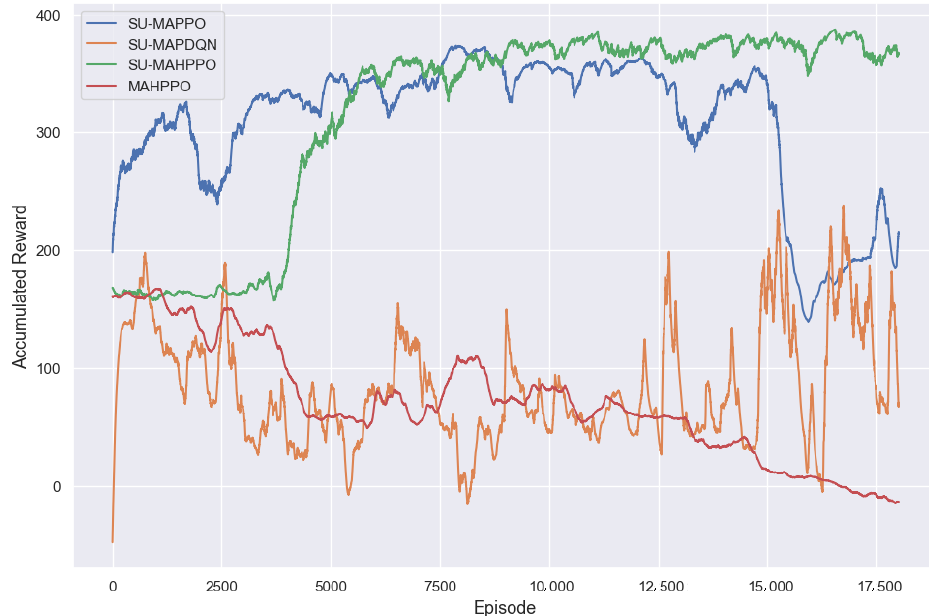
Figure 3. Convergence with different algorithms.